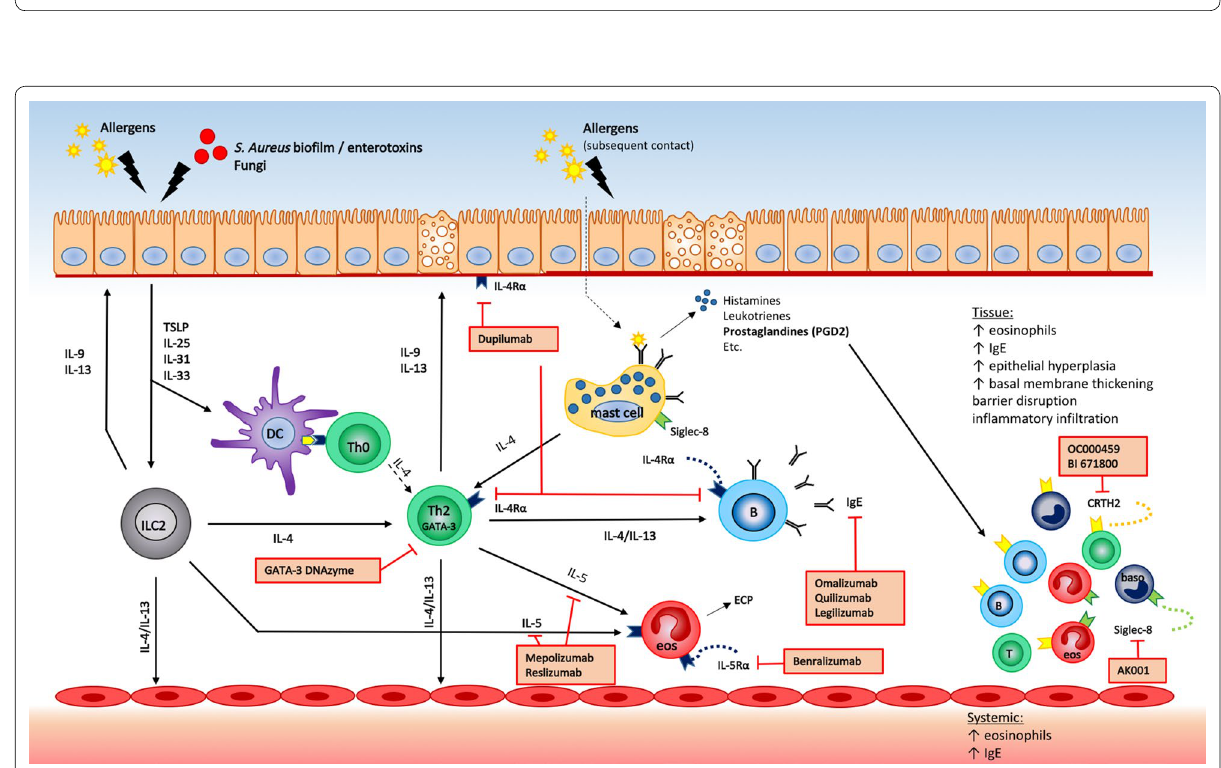
Fig. 2 Type 2 inflammation and biologicals. B B cell; baso basophil; DC dendritic cell; ECP eosinophilic cationic protein; eos eosinophils; ILC2 type 2 innate lymphoid cell; Th T helper